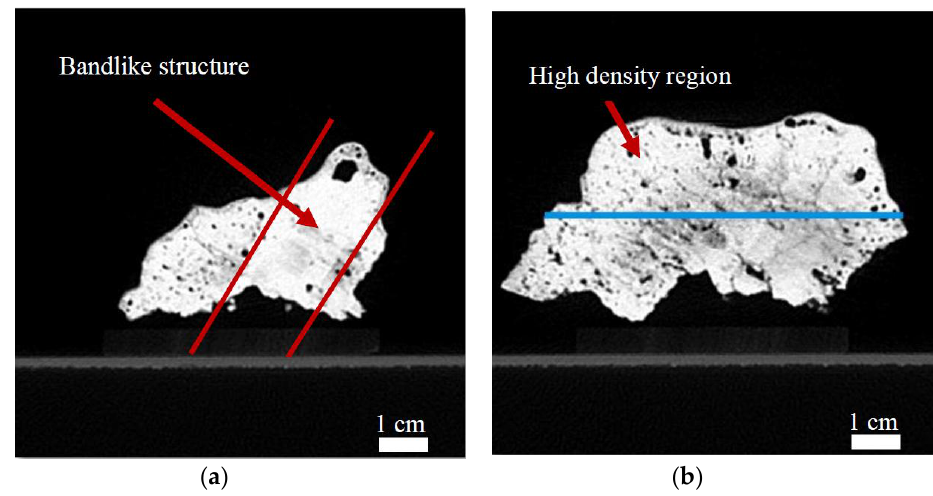
Figure 3. X-ray images of sample A: ( a ) Location represented by the yellow line in Figure 2 and bandlike structure (highlighted by the red lines); ( b ) Location represented by the red line in Figure 2.